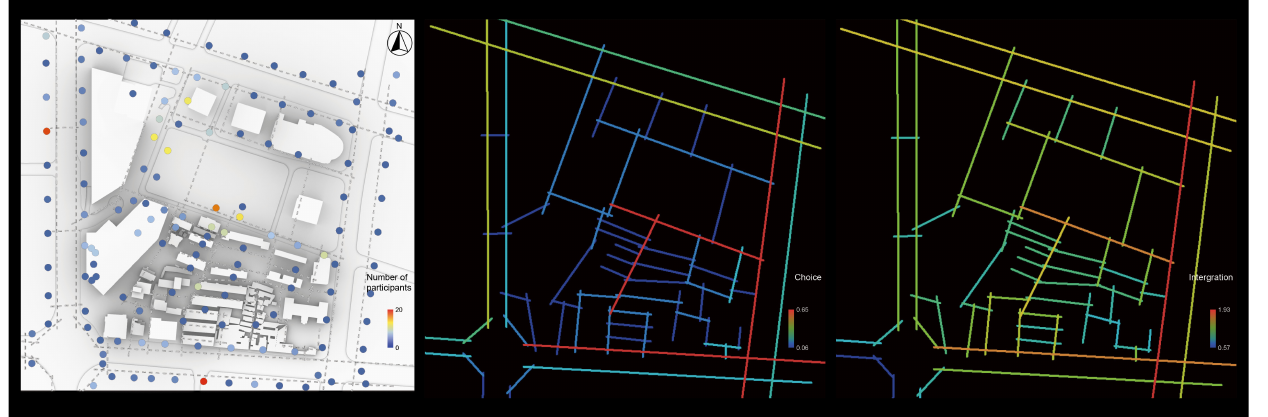
Figure 6. On the left, the distribution of the number of residents’ public participation. In the middle, the analysis of the spatial syntax on the choice value of urban morphology. On the right, the spatial syntax analysis of the integration value of urban